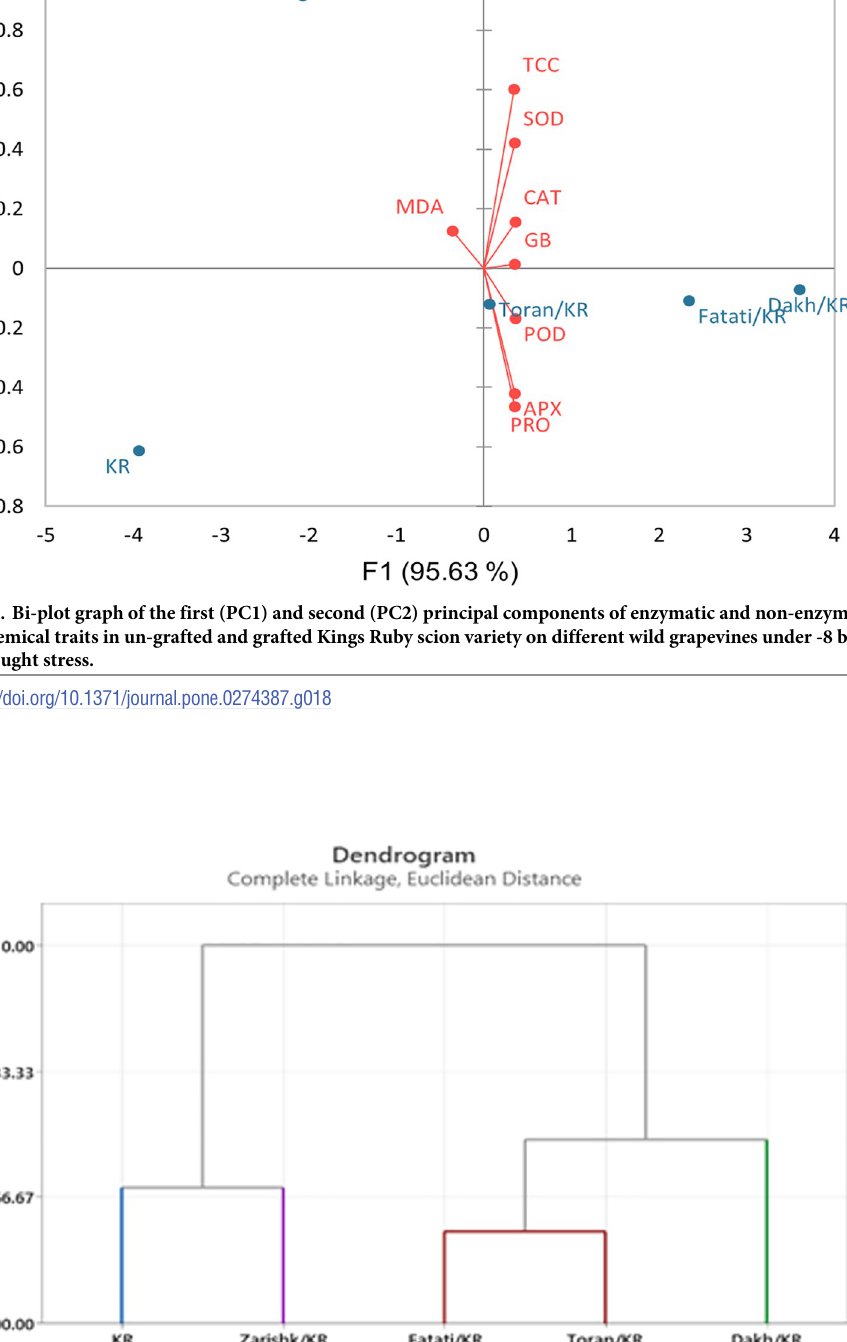
PLOS ONE | https://doi.org/10.1371/journal.pone.0274387 September 13,